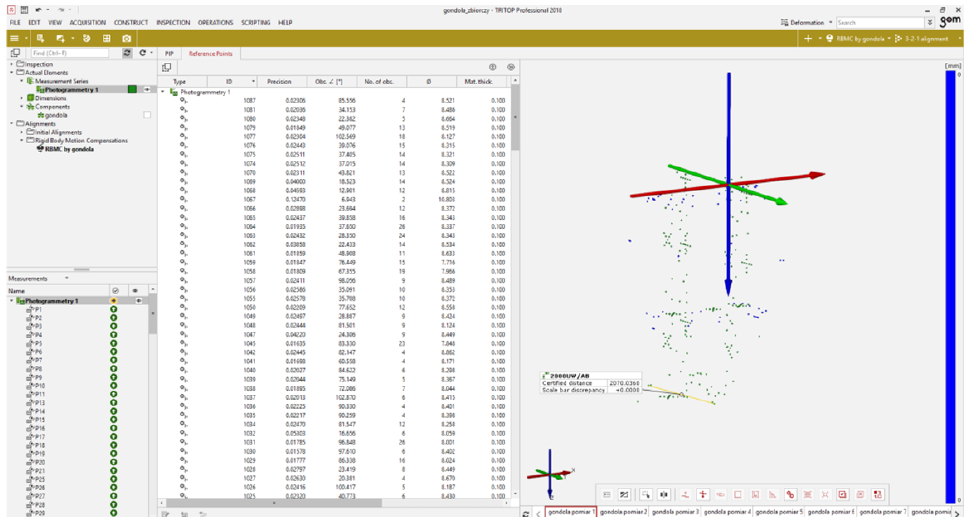
Figure 11. Screenshot from the TRITOP Professional program. The image shows a cloud of measure- ment and reference points along with the adopted coordinate system.